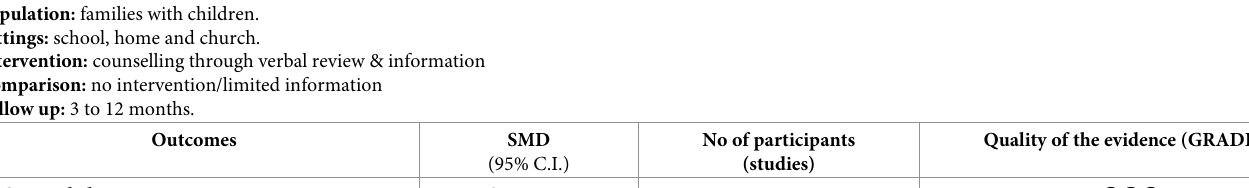
Table 5. Summary of findings. Intervention vs Control. Population: families with children. Settings: school, home and church. Intervention: counselling through verbal review & information Comparison: no intervention/limited